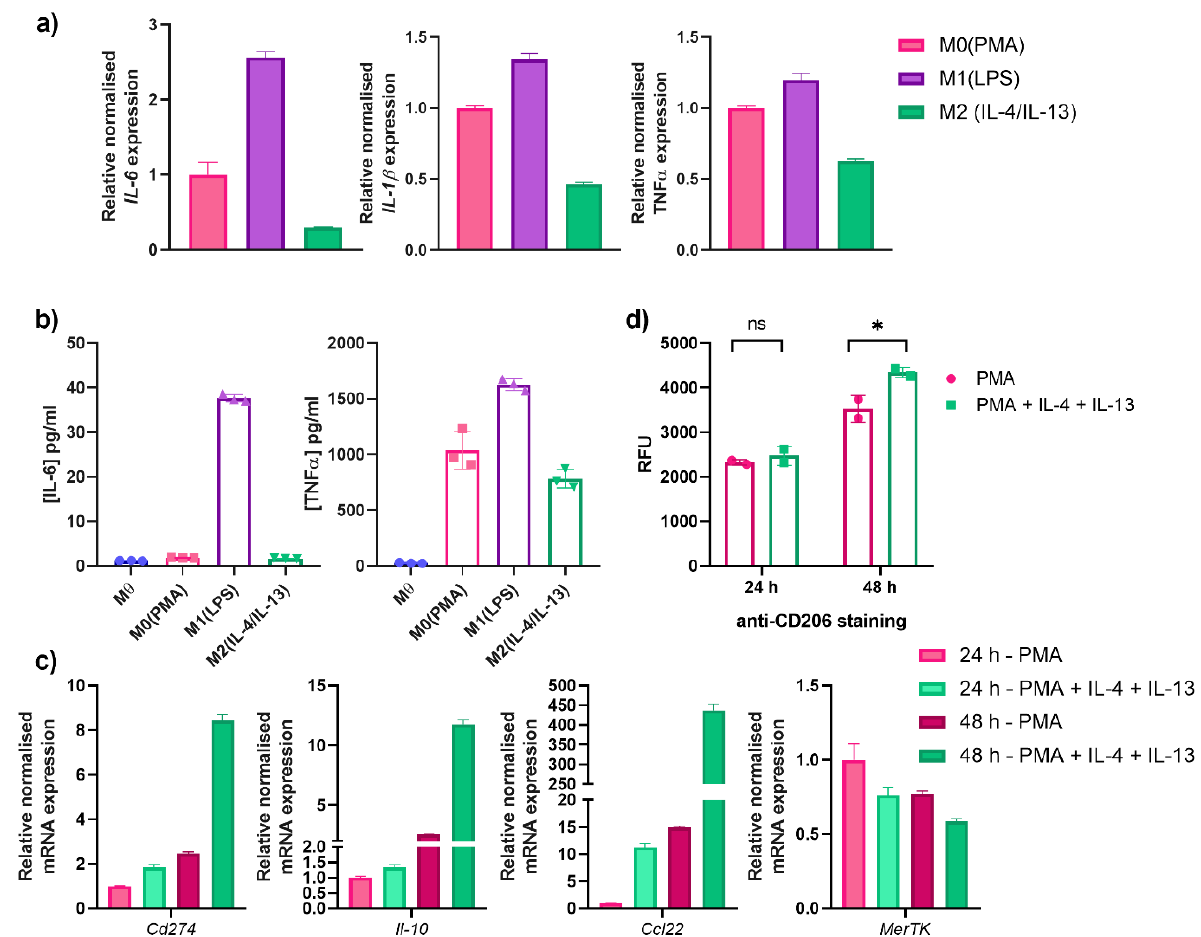
Figure 5. Differentiation of macrophage-like THP-1 cells to M1- and M2-state. ( a ) Gene expression analysis of THP-1 cells differentiation with PMA (M0—pink), LPS (M1—violet) or IL-4/IL-13 (M2—teal) for 24 h. The data are normalised to housekeeping genes and set relative to the M0(PMA) control. ( b ) Secretion of IL-6 and TNF α in cell culture supernatants as determined by ELISA. ( c ) Gene expression analysis of PMA- (M0—pink shades) and PMA/IL-4/IL-13-incubated cells (M2—greens shades) after either 24 h (lighter colours) or 48 h (darker shades) incubation. Analysis was performed by normalising the data to housekeeping genes and setting the values relative to the M0 24 h control. ( d ) CD206-cell surface staining of differentiated cells by flow cytometry. After differentiation, THP-1 cells were stained with anti-CD206 PE-conjugate and measured by flow cytometry. The mean relative fluorescence units (RFU) were determined and plotted for each individual duplicate. One-way ANOVA analysis performed using GraphPad Prism: ns: non-significant, * p value <